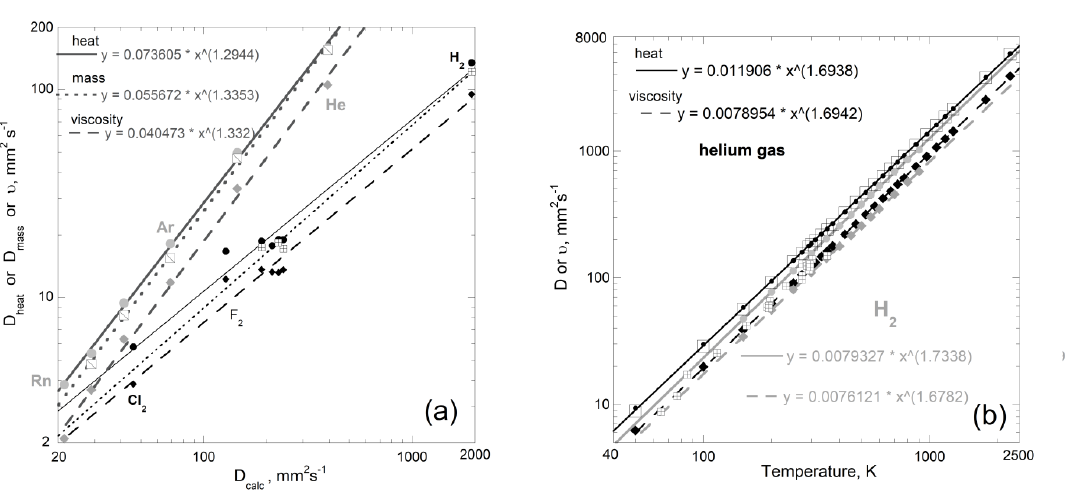
Figure 3. Data on transport properties. Circles and solid line = thermal diffusivity. Squares and dotted line = mass self-diffusivity. Diamond and dashed line = kinematic viscosity. Least squares fits are shown: ( a ) comparison of physical properties at ambient condition to EKTG of hard spheres (Equation (7)). From data compiled in [33] (Table 5.2). For clarity, fits are shown for noble gas only; ( b ) dependence of measured transport properties on temperature. Data on He from Kestin et al. [54]. Data on H 2 from the compilation of Suárez-Iglesias et al. [55] and various sources, listed in [33] (Table 5.2). For clarity, fits for D mass are omitted.